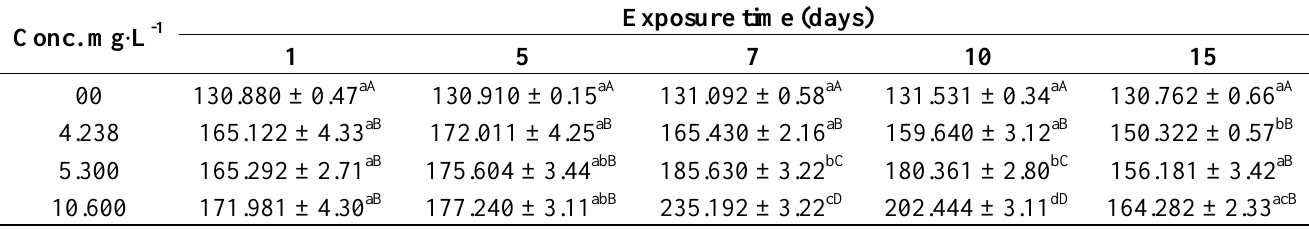
Table 6. Activity of catalase (unit/mg protein) in the liver of C. punctatus exposed to sub-lethal doses of atrazine for 1–15 days.